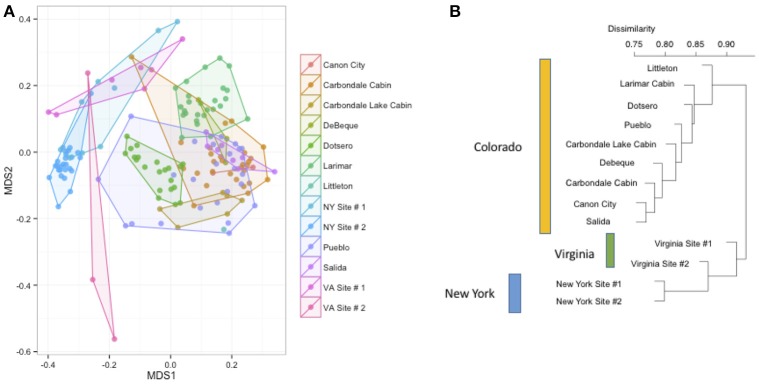
(A,B) Differences in bacterial community composition of all bat samples by sample site. NMDS ordination of all bats from Figure 2 colored by site (stress = 0.18). A PERMANOVA analysis indicates that site is a significant driver of community composition (R2: 0.26, p-value < 0.001). At right, the Bray-Curtis dissimilarity between sites plotted as a dendrogram.